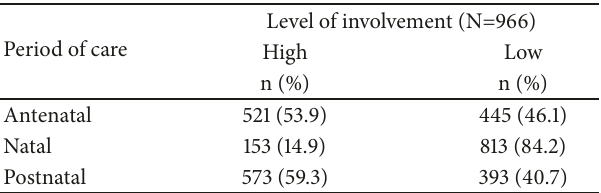
Table 3: Level of men’s involvement in maternity care during antenatal, natal, and postnatal